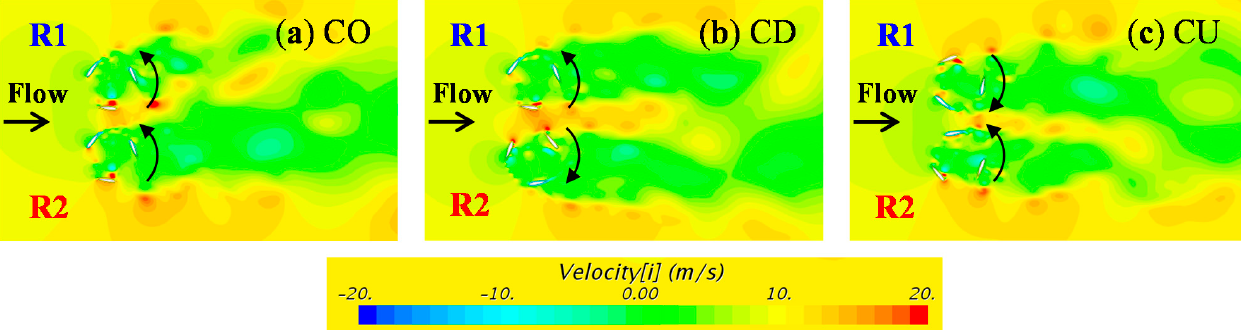
Figure 6. Color contours of flow velocity ( x –direction component) when gap / D = 0.5: ( a ) CO layout; ( b ) CD layout; ( c ) CU layout.